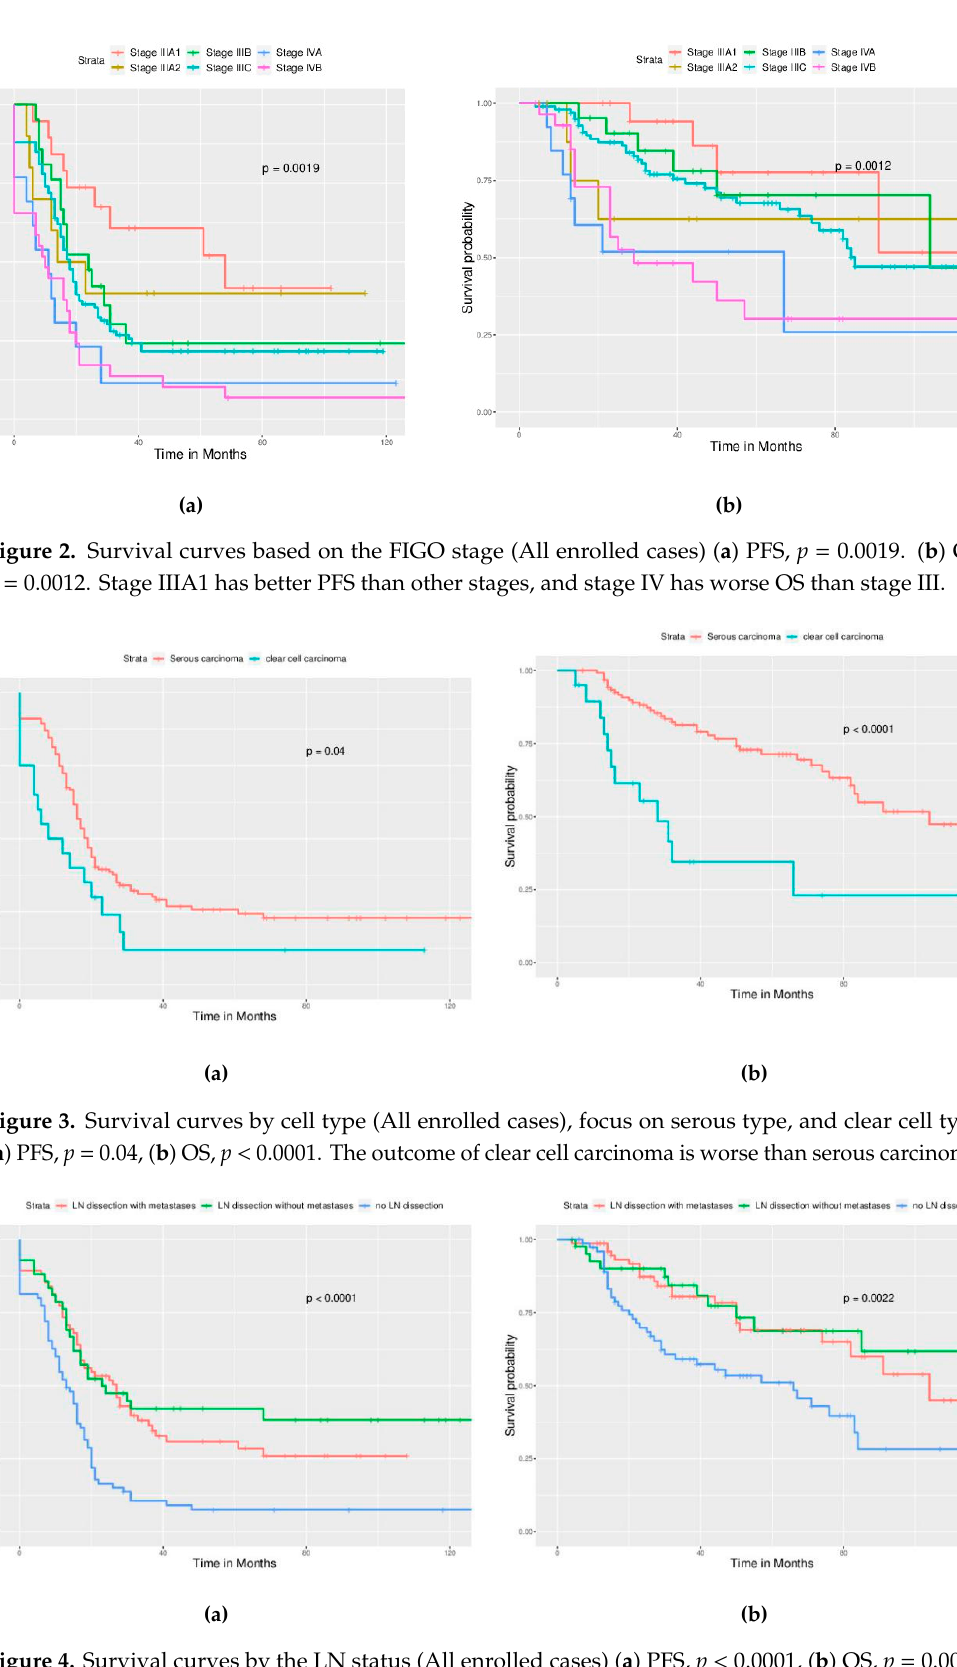
( b ) Figure 5. Survival curves by adjuvant chemotherapy regimens (All enrolled cases). However, no statistical significance is observed. ( a ) PFS, p = 0.32, ( b ) OS, p = 0.55. 3.2. Analysis of Cases with Optimal Debulking Surgery 3.2.1. Factors Affecting Disease Recurrence/Persistence and Survival The FIGO stage ( p = 0.023) and LN status ( p = 0.015) still significantly affected recurrence, and cell types and adjuvant chemotherapies did not (Table 8). Furthermore, LN status ( p = 0.01) significantly affected survival, but FIGO stage, cell types, and adjuvant chemotherapy did not (Table 9). Again, choice of adjuvant chemotherapy played little role in recurrence/persistence and survival even though optimal debulking was achieved.